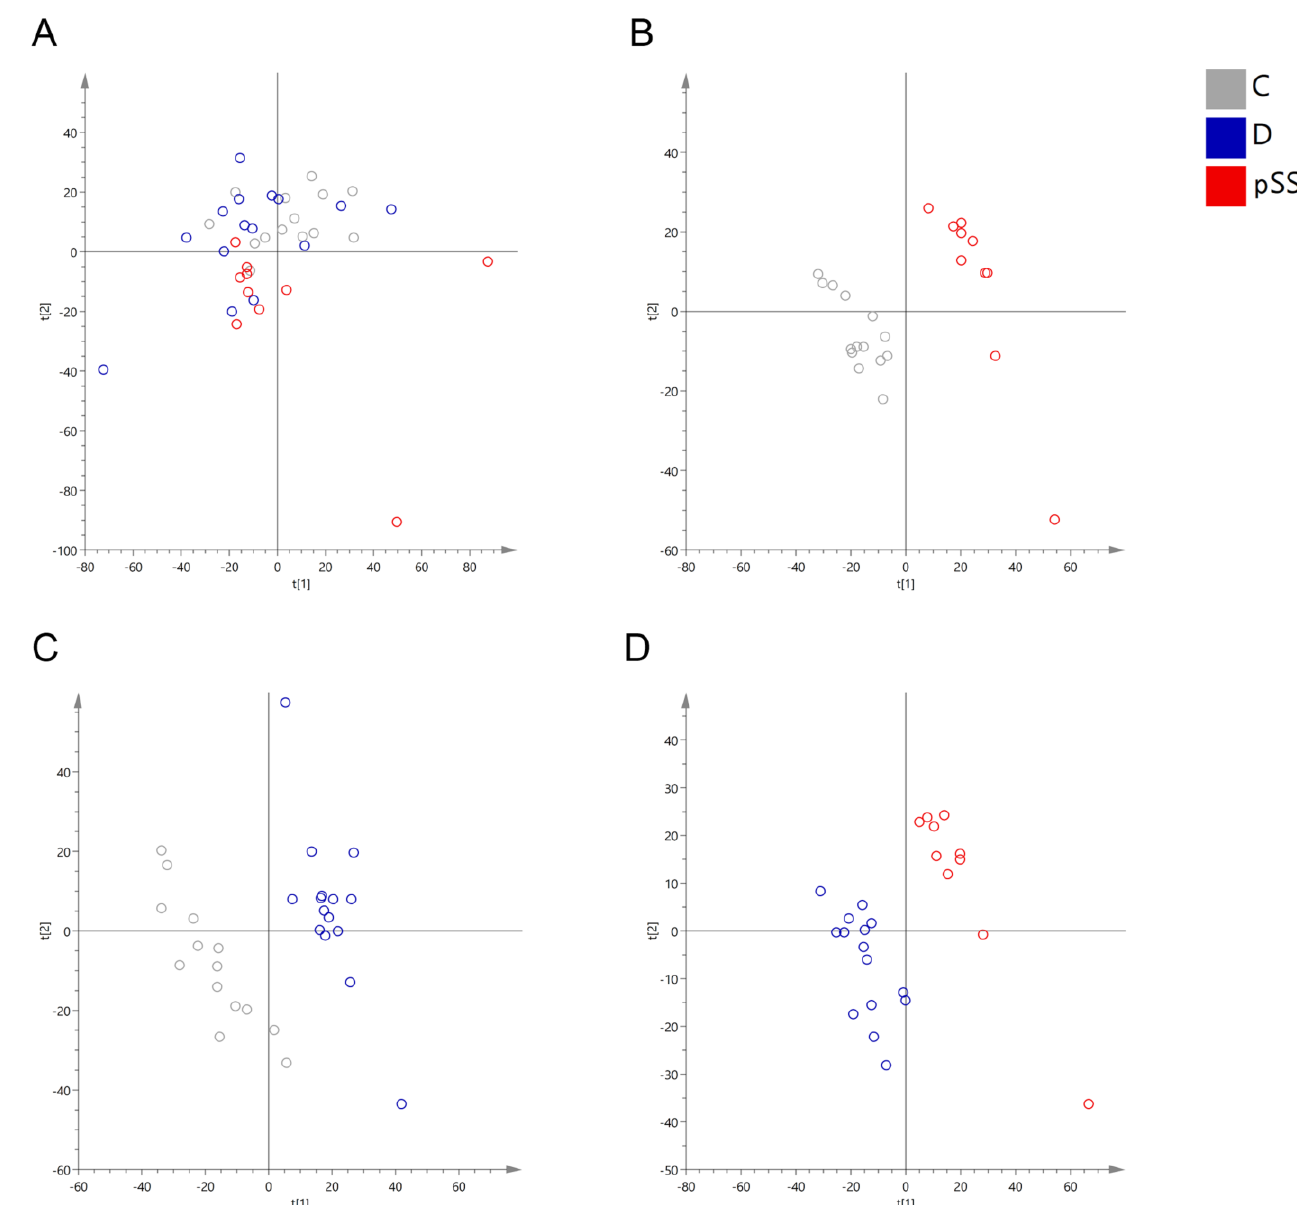
Figure 1. Results of principal component analysis of the metabolomics data. In the principal component analysis (PCA), a separation of the groups can be seen, in which the metabolite profile of the saliva samples from the Sjögren’s syndrome patients before drug treatment (pSS) are separated from the metabolite profile of saliva samples from the HC (C), whereas Sjögren’s syndrome patients with LDD treatment (D) are mixed with the first two groups ( A ). Partial least sum of squares (PLS-DA) models between the controls and the Sjögren’s syndrome patients without drug treatment (( B ): Three components, R2Y (cumulative) = 0.99, Q2 (cumulative) = 0.77), between the controls and Sjögren’s syndrome patients with low-dose doxycycline treatment (( C ): Four components, R2Y (cum) = 0.99, Q2 (cum) = 0.67), and Sjögren’s syndrome patients with and without drug treatment (( D ): Two components, R2Y (cum) = 0.94, Q2 (cum) = 0.39).